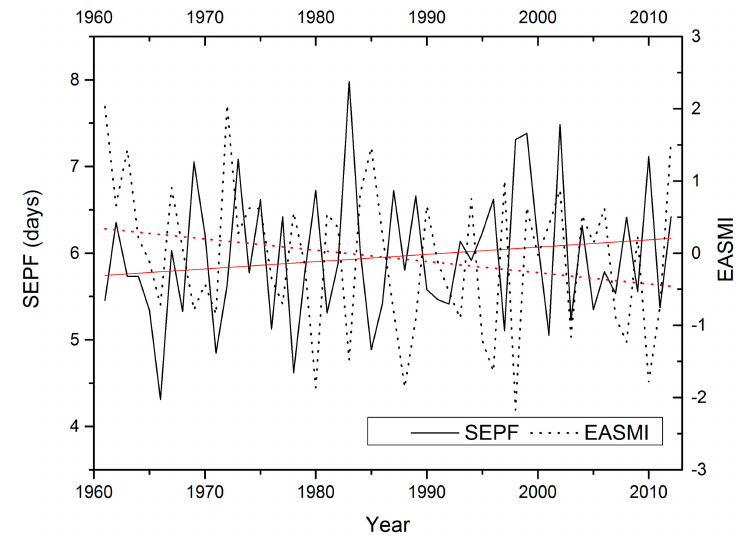
Figure 9. Interannual variations of SEPF and EASMI in the MLR-YR from 1961 to 2012